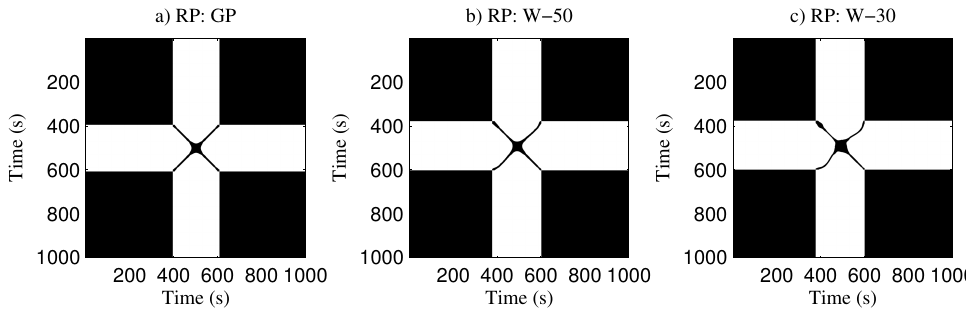
Figure 11. Recurrence plot for each peak analyzed with a threshold distance of (cid:101) = 0.10. ( a ) Gaussian peak; ( b ) smoothed peak for a width of 50 points; ( c ) smoothed peak for a width of 30